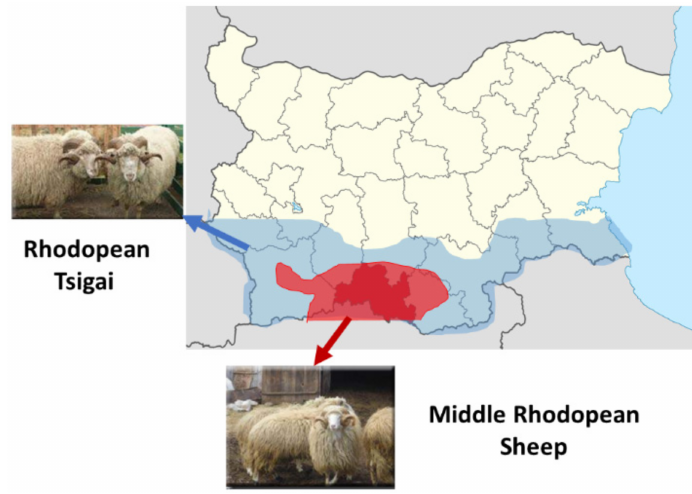
Figure 1. Geographic distribution of the studied sheep breeds in Bulgaria.